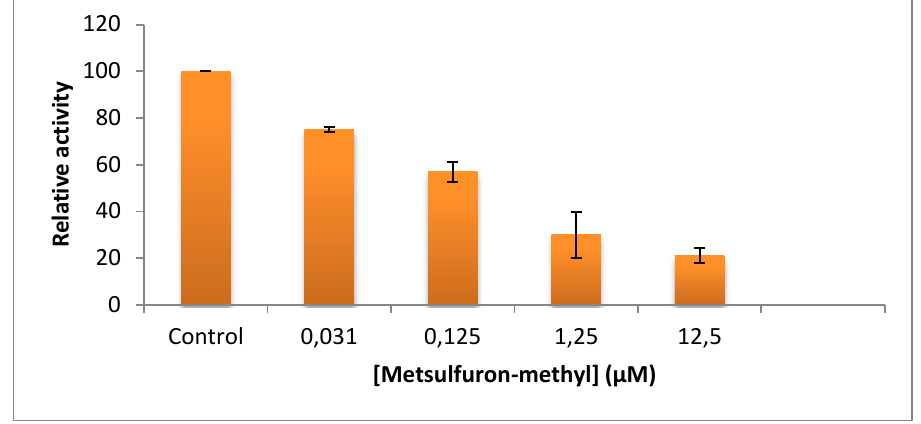
Figure 2. Effect of metsulfuron-methyl on the activity of recombinant